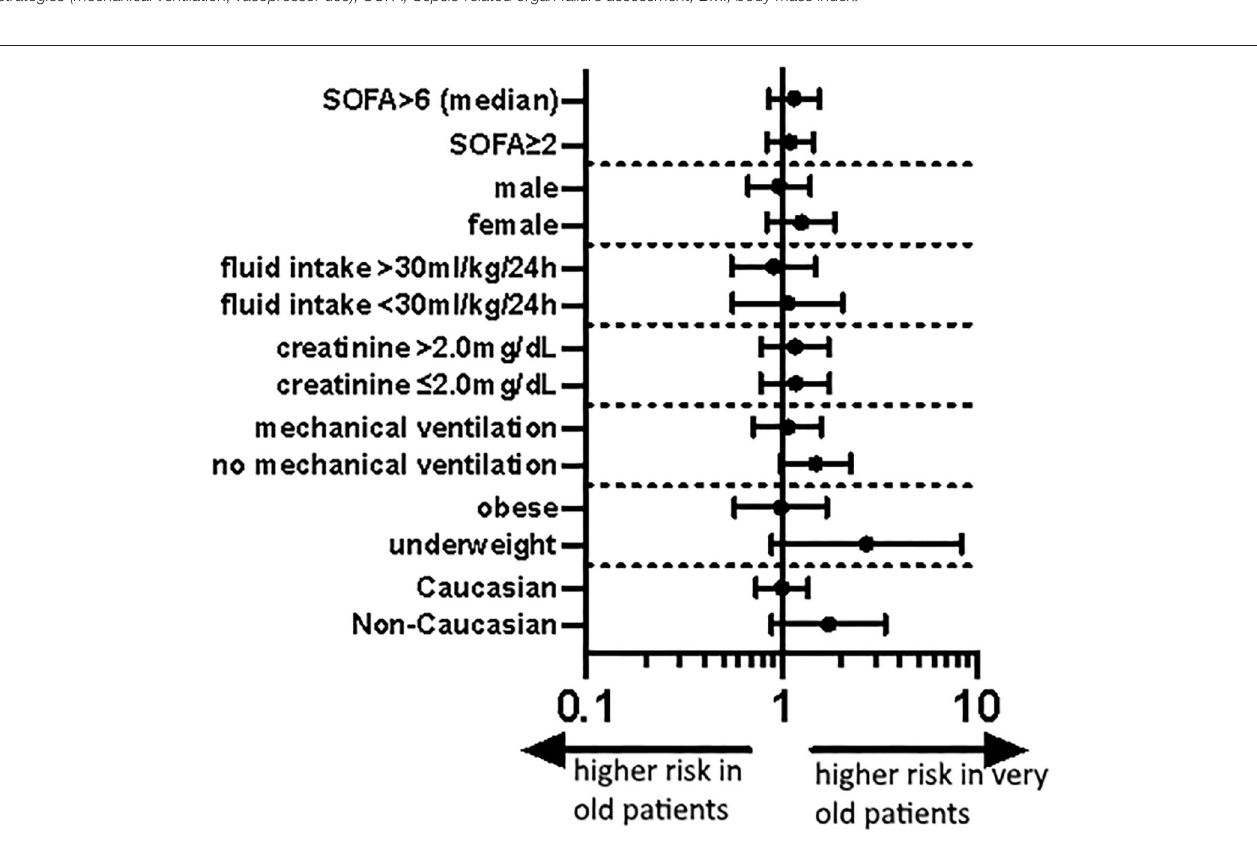
and that these two are not necessarily the same thing